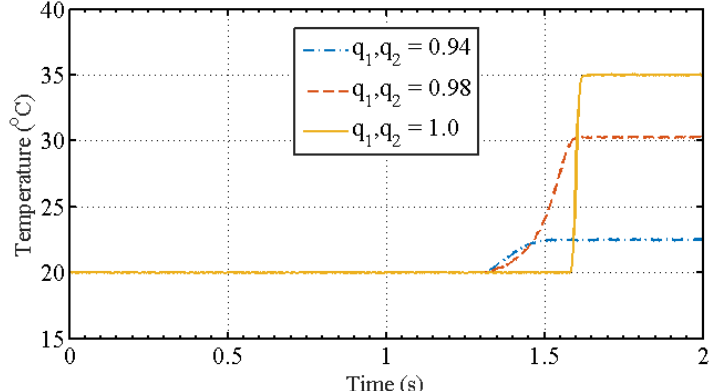
Figure 20. The output temperature in cold fluid as q 1 , q 2 ≤ 1.